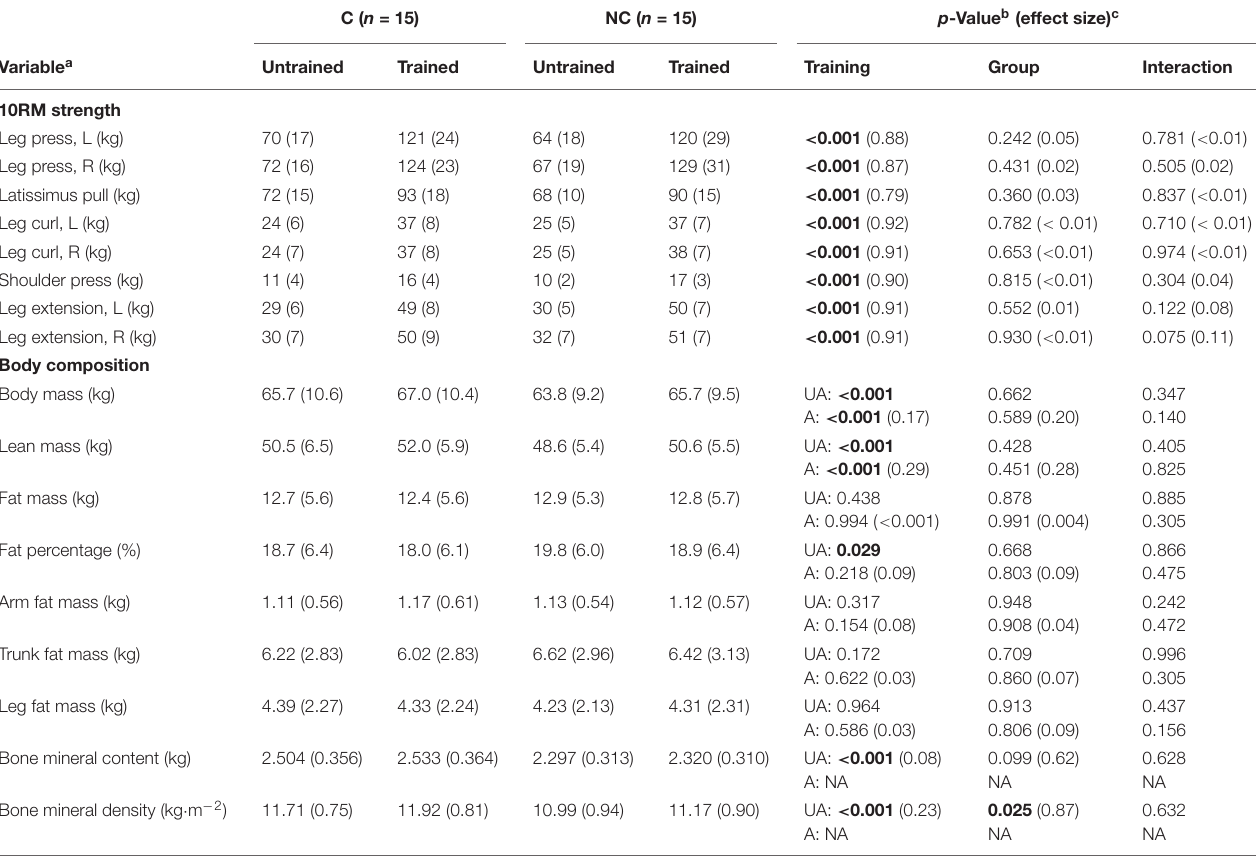
TABLE 2 | Changes in ten-repetition maximum (10RM) strength and body composition. C ( n = 15) NC ( n =